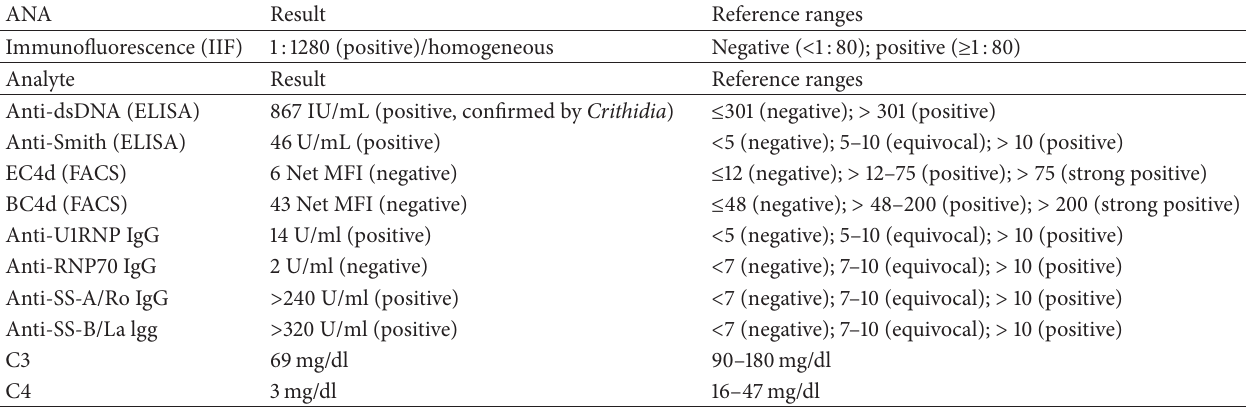
Table 2: April 1,